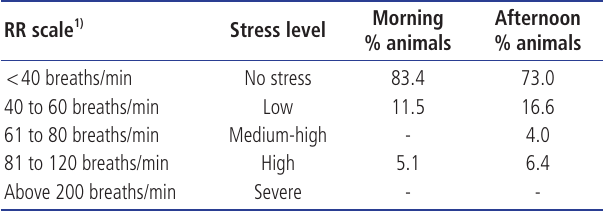
Table 2. Respiratory rate (RR) classification of the sheep according to the period of the day RR scale 1) Stress